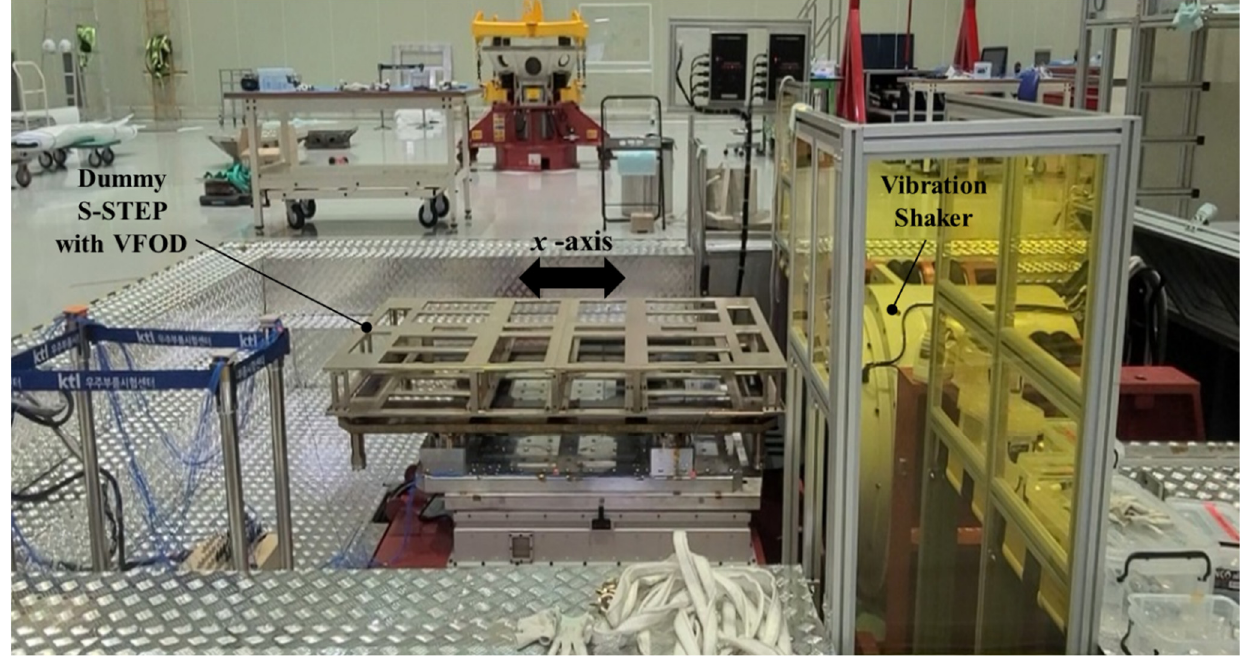
Figure 19. Launch vibration test setup of VFOD with dummy S-STEP for x -axis excitation.